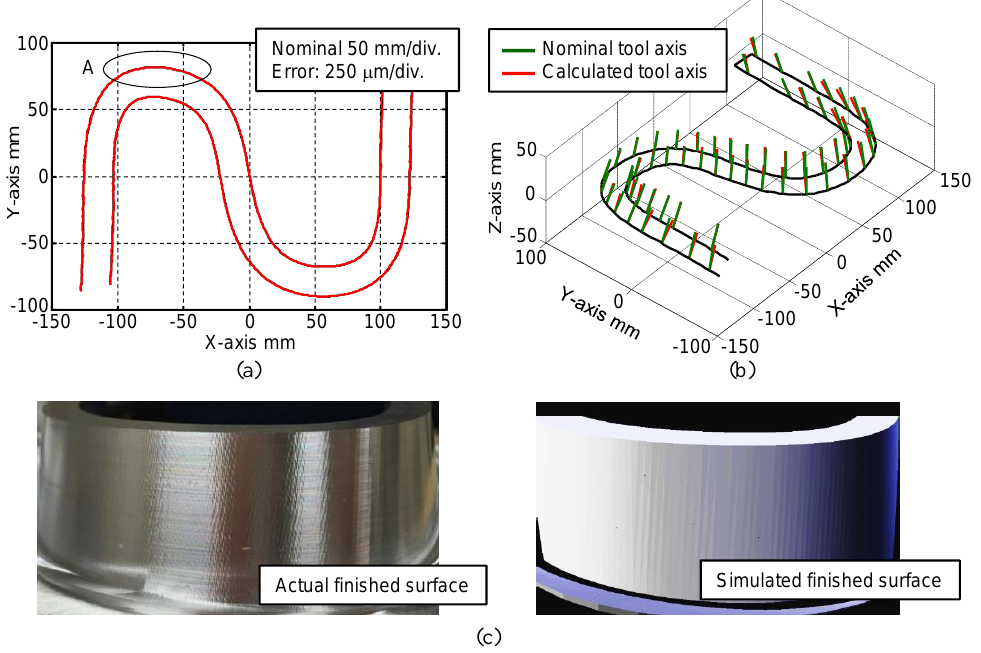
Figure 8. Tool-motion trajectory and finished surface corresponding to the 0.01-mm tolerance case: ( a ) Motion trajectory of tool center-point; ( b ) Tool orientation error; ( c ) Actual and simulated finished surfaces.